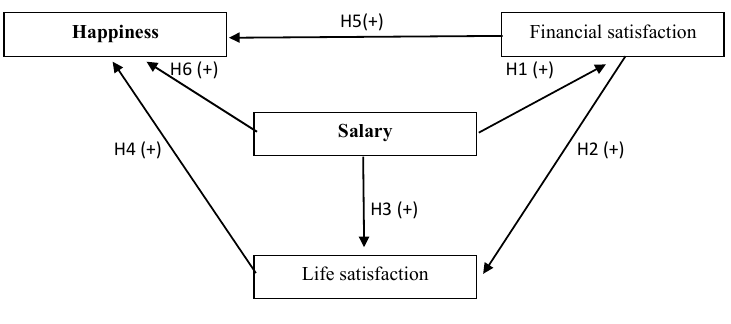
Figure 1. Research model.